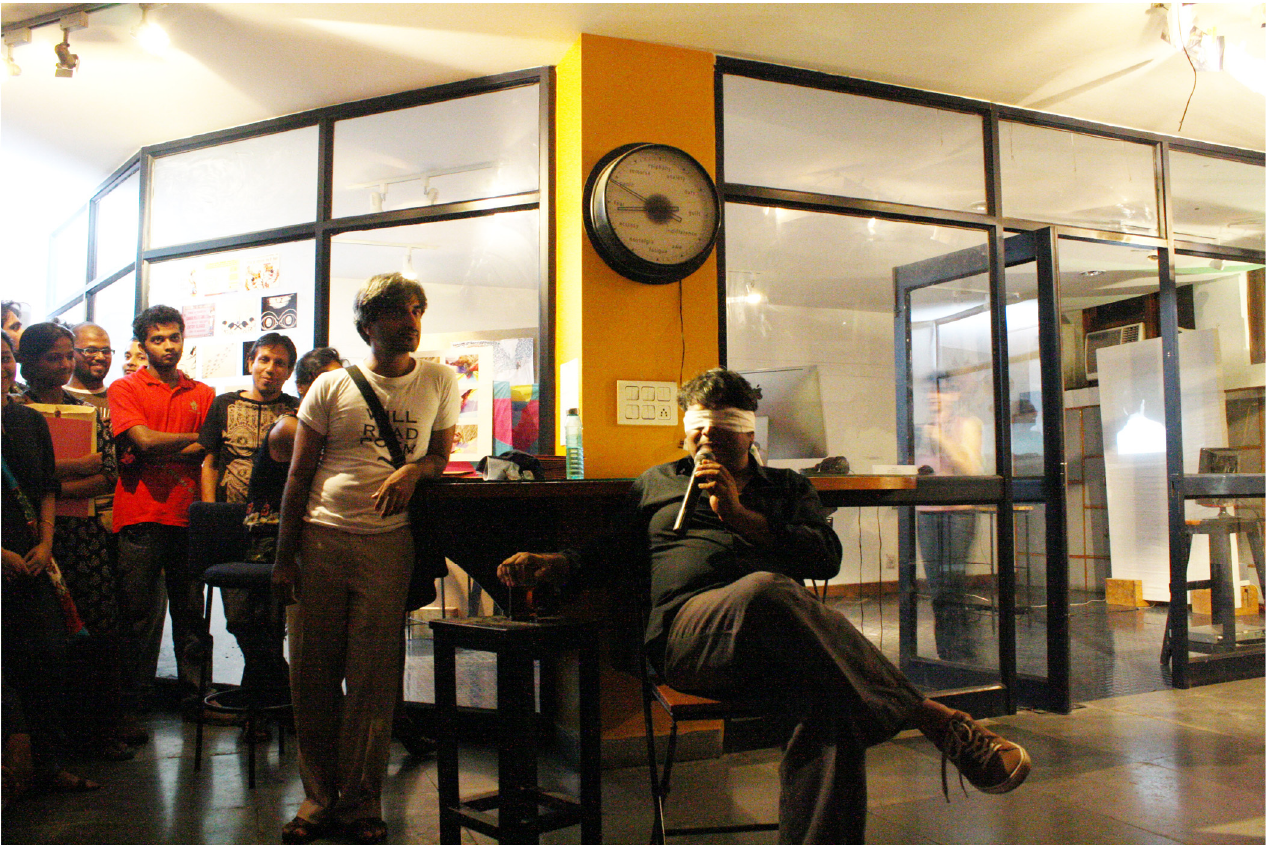
Figure 1. Sarai, Extraterrestrial Basement , Delhi, 2010. Image courtesy Shamsher Ali.